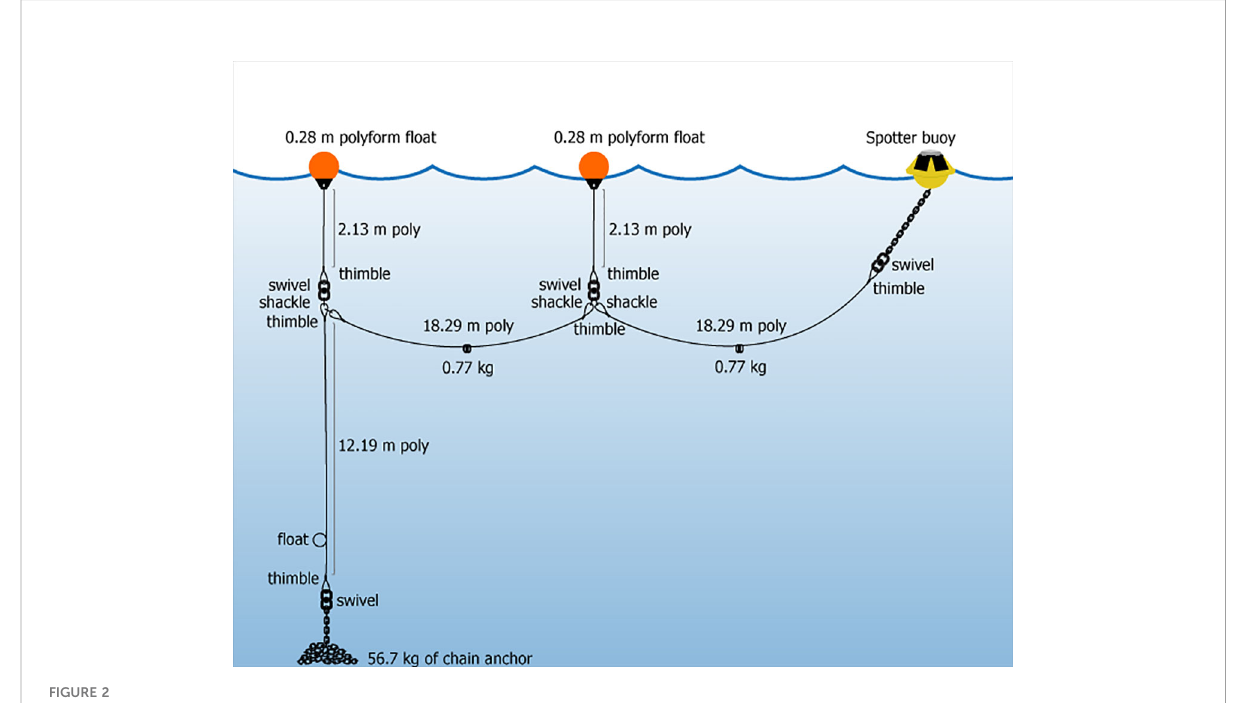
FIGURE 2 Diagram depicting the Spotter buoy